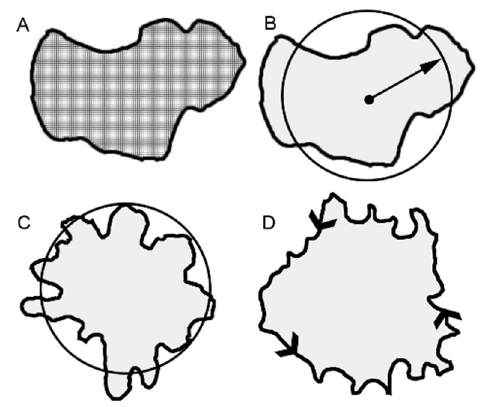
Figure 1. Distinctive morphometric measures of the loaded methylene blue tracer. The total area of the tracer was reflected in several measures that assess cumulative pixel area. Examples of total area ( A ), mean radius ( B ), shape factor ( C ) and perimeter ( D ) are shown. ( A ), mean radius ( B ), shape factor ( C ) and perimeter ( D ) are